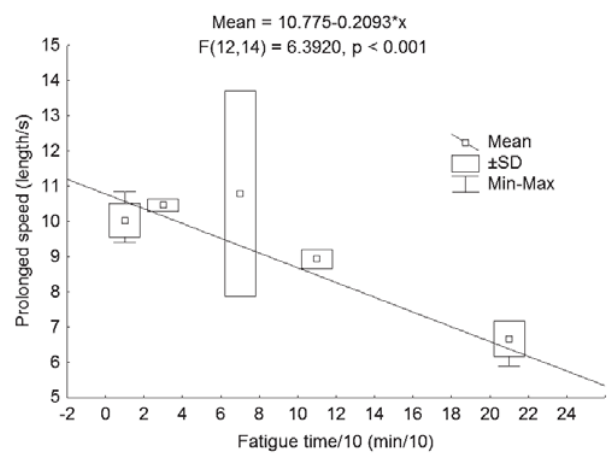
Fig. 7. Mean (± standard deviation – SD; minimum – Min; and Maximum – Max) values of prolonged speed (length/s) per fatigue time (min/10) for the piau Leporinus reinhardti .